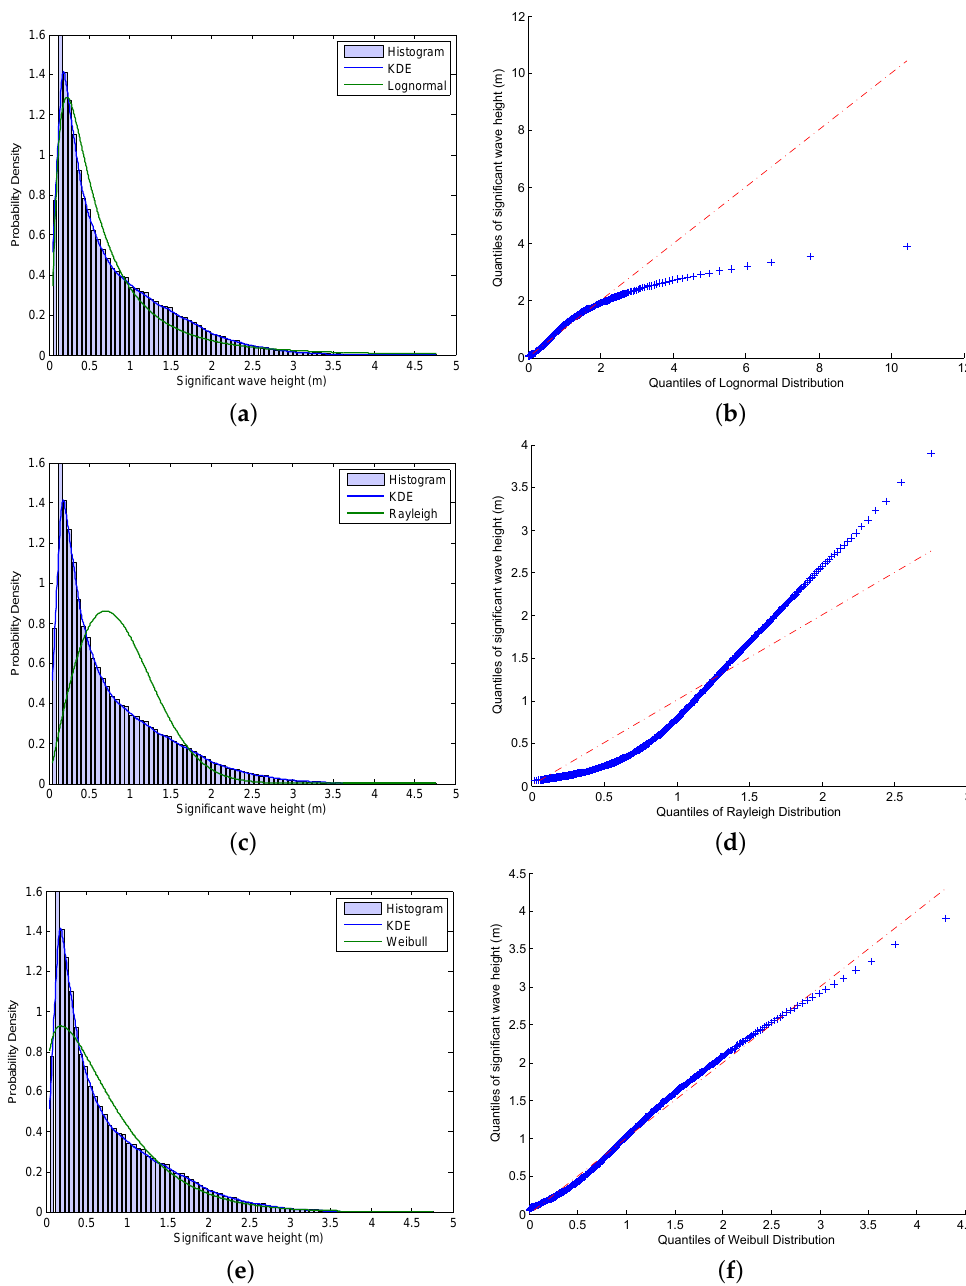
Figure 10. ( a – f ) Estimated kernel density of the significant wave heights and the fitted Lognormal, Rayleigh and Weibull distributions of the significant wave heights with the corresponding Q-Q plots of the distributions of the significant wave heights. Table 2. R-square test and the corresponding parameters for each fitted single distribution. Root mean squared error: